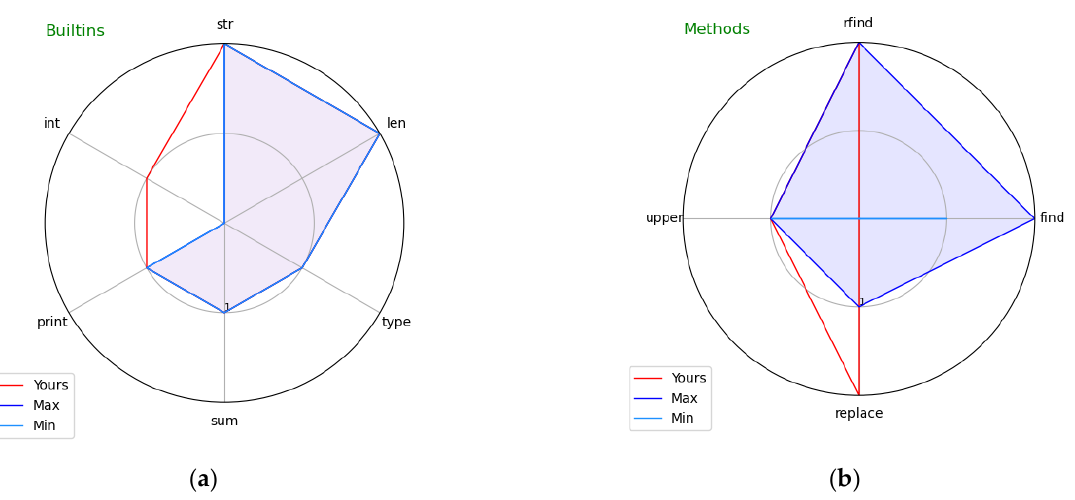
Figure 2. Visual profiles of exemplary students’ programs showing: ( a ) Built-ins and ( b ) Methods.